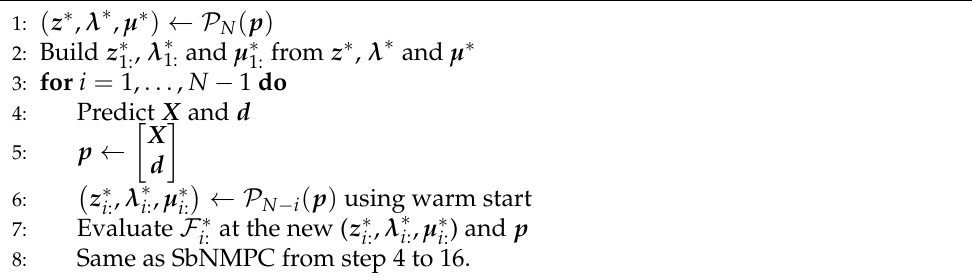
Algorithm 3 Working principle of the advanced-step NMPC